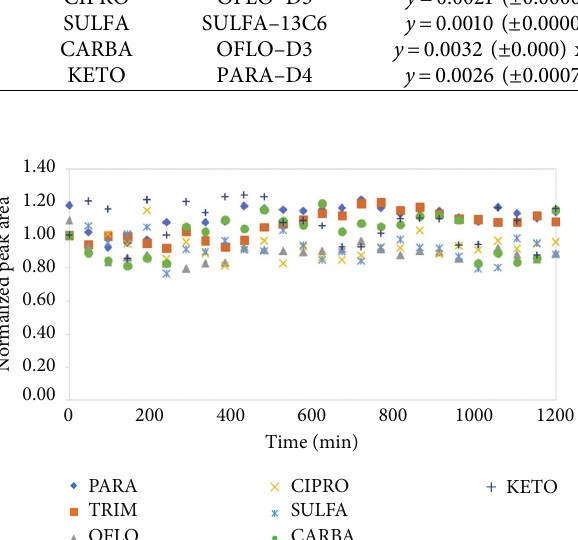
Figure 4: Stability of target compounds in three thawing-freezing cycles at 10 µ g L − 1 (low concentration); 200 µ g L − 1 (middle con- centration); 500 µ g L − 1 (high concentration).